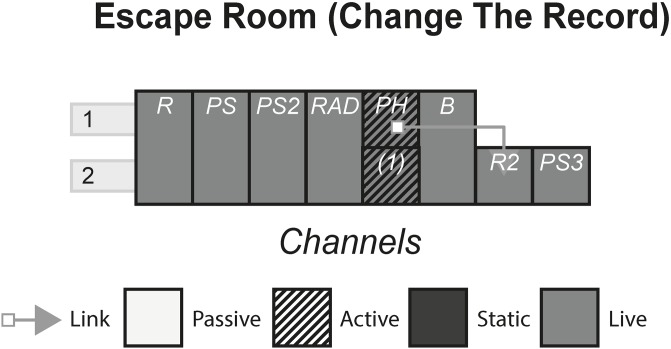
Change The Record.